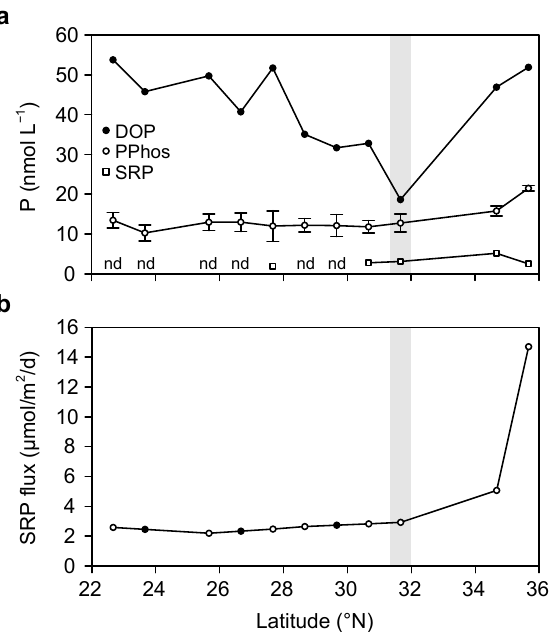
Fig. 2. Phosphorus pools as a function of latitude across the BV47 cruise transect (see Fig. 1). Shaded region represents the approxi- mate location of BATS. (a) Surface concentrations of dissolved or- ganic phosphorus (DOP, filled circles), bulk particulate phospho- rus (PPhos, open circles; shown as means ± SE), and soluble reac- tive phosphorus (SRP, open squares, “nd” denotes stations that were below detection). (b) Estimated vertical SRP flux (µmolm − 2 d − 1 ) across the base of the euphotic zone. Flux was calculated as the product of the vertical concentration gradient (from 80 to 160m) and diffusivity coefficient (0.000035m 2 s − 1 ; Ledwell et al., 2008). Filled circles represent stations where the SRP flux was linearly in- terpolated from the two immediately adjacent values because the concentration gradient was not measurable.